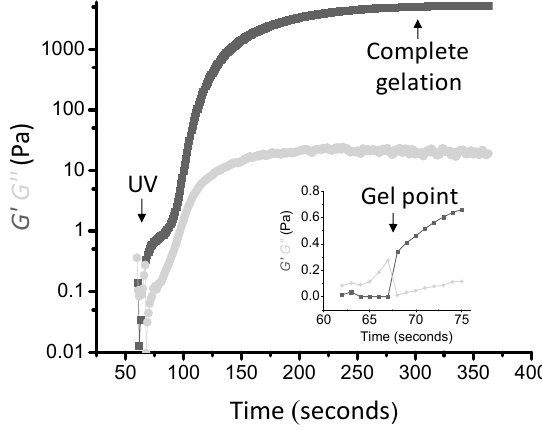
Figure 3. Typical gelation kinetics profile of thiol-ene mixture CollPEG4 (LAP 0.5% ( w / v )). Dark grey: storage modulus ( G’ ); light grey: loss modulus ( G’’ ). UV light was activated 60 s after the start of the time sweep measurement, resulting in complete gelation after nearly 300 s. The inner image presents a zoomed-in plot of the initial stage of gel formation, indicating a gel point after just 7 s of UV activation.